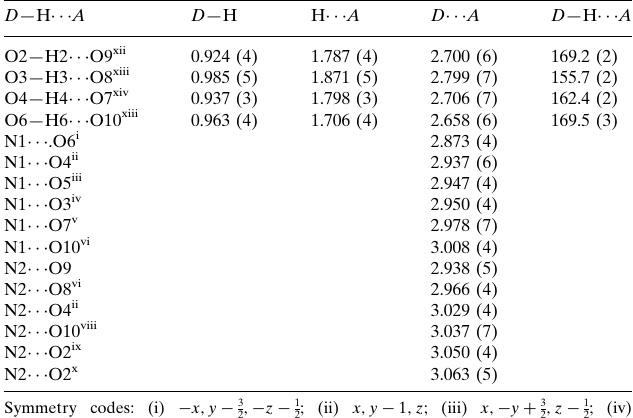
Hydrogen-bond and short contact geometry (A˚ , (cid:3)